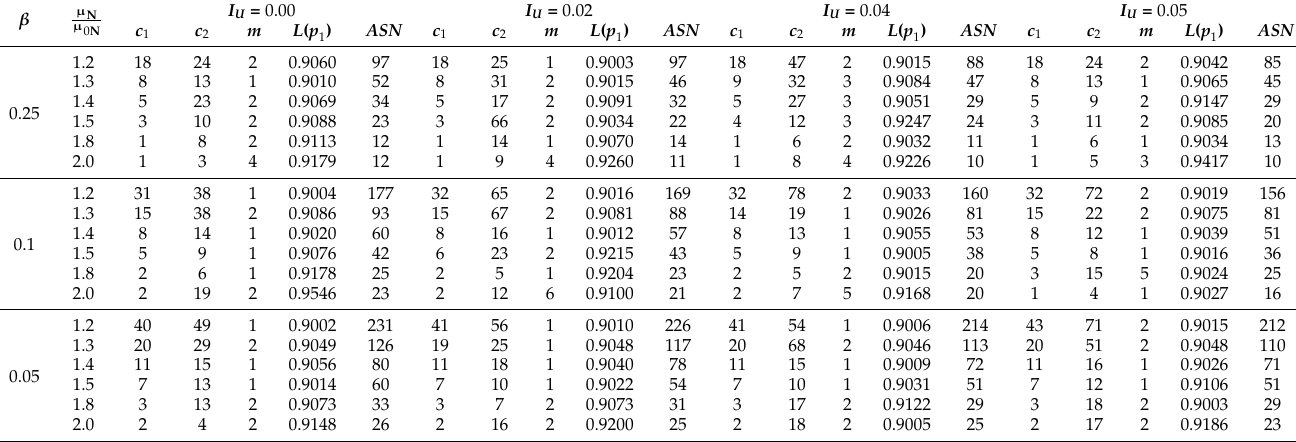
Table 3. The MDS design values for α = 0.10, ν = 2.5, and a =